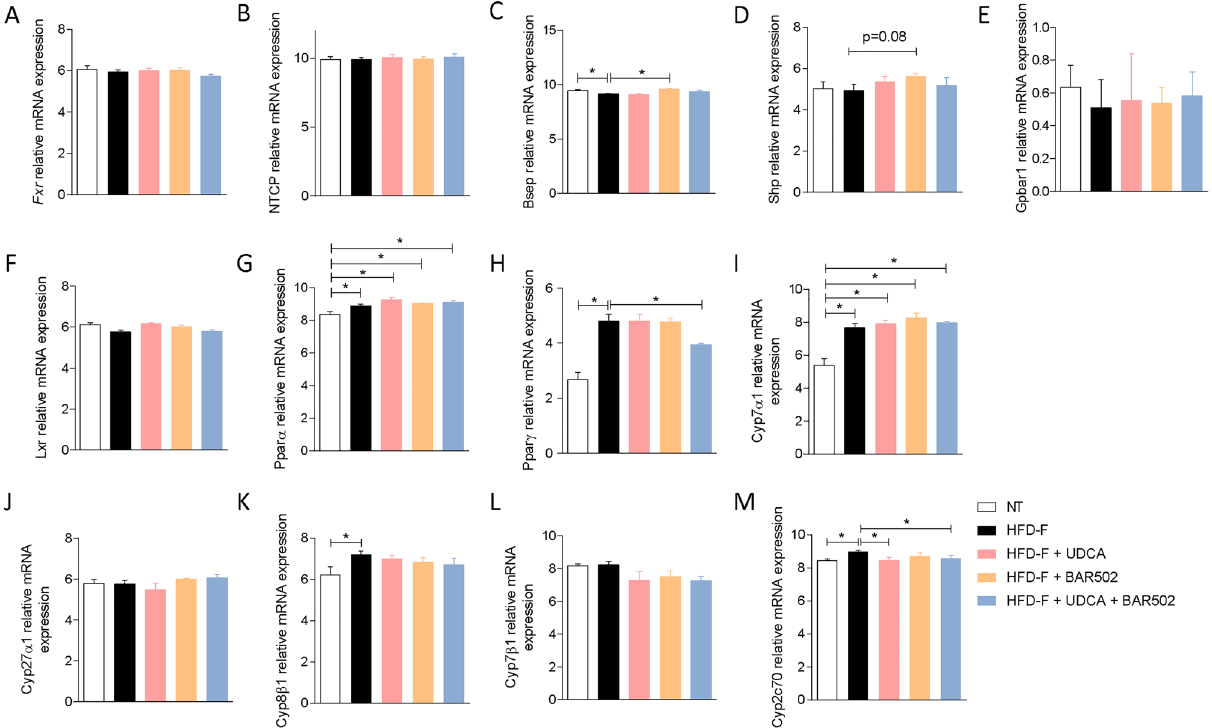
Figure 5. Hepatic expression of receptors and genes involved in bile acid synthesis. The expression levels of genes are extracted from RNA-seq